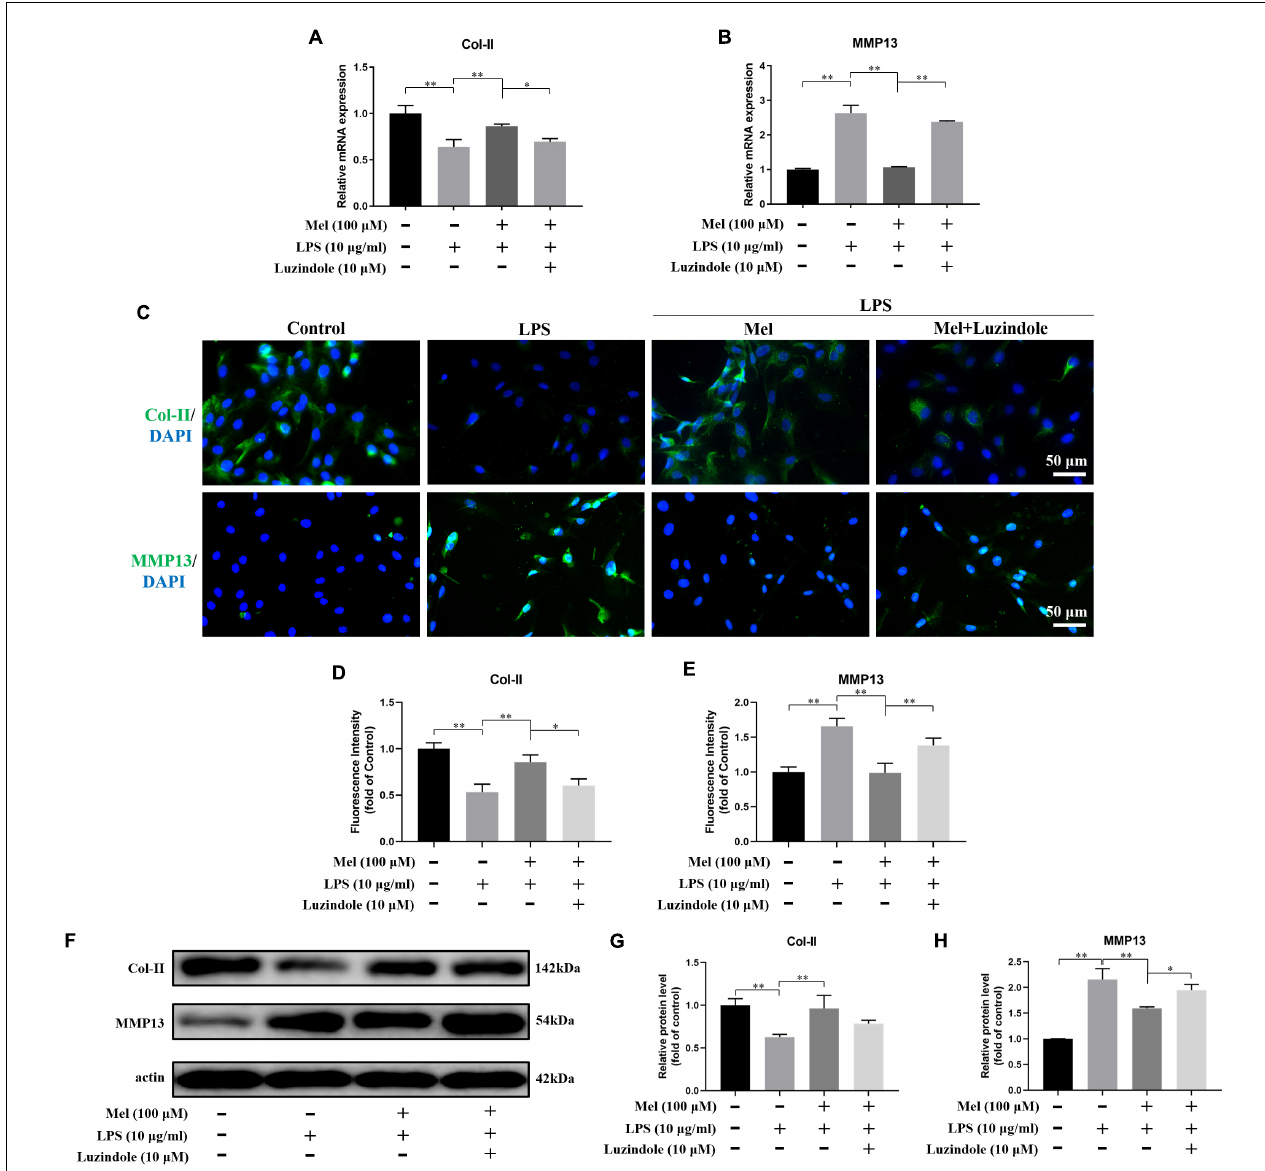
FIGURE 6 | Melatonin (Mel) alleviated the degeneration of endplate cartilaginous cells (EPCs) through binding to its specific receptors. (A,B) qRT-PCR analysis of the relative mRNA expression of type II collagen (Col-II) (A) and matrix metalloproteinase-13 (MMP13) (B) under lipopolysaccharide (LPS), Mel, and Luzindole treatment. (C) Immunofluorescence staining of Col-II and MMP13 under LPS, Mel, and Luzindole treatment. (D,E) Quantitation of fluorescence intensity of Col-II and MMP13. (F) Western blotting for proteins of Col-II and MMP13 under LPS, Mel, and Luzindole treatment. (G,H) Quantitation of relative protein level of Col-II and MMP13 ( ∗ P < 0.05, ∗∗ P <